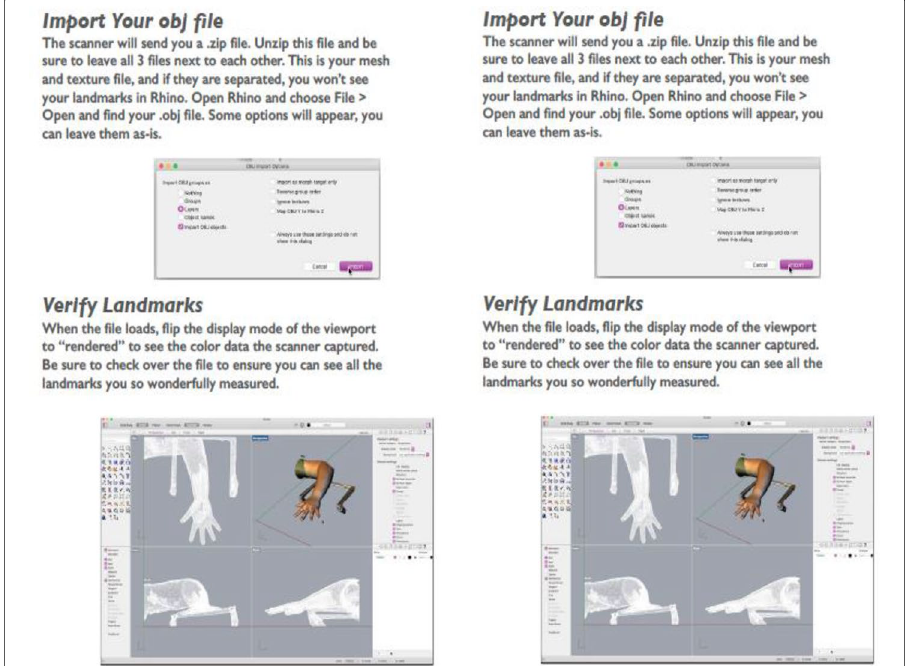
Fig. 3 Example of 3D hand scan processing in Rhino software (Sokolowski and Corr